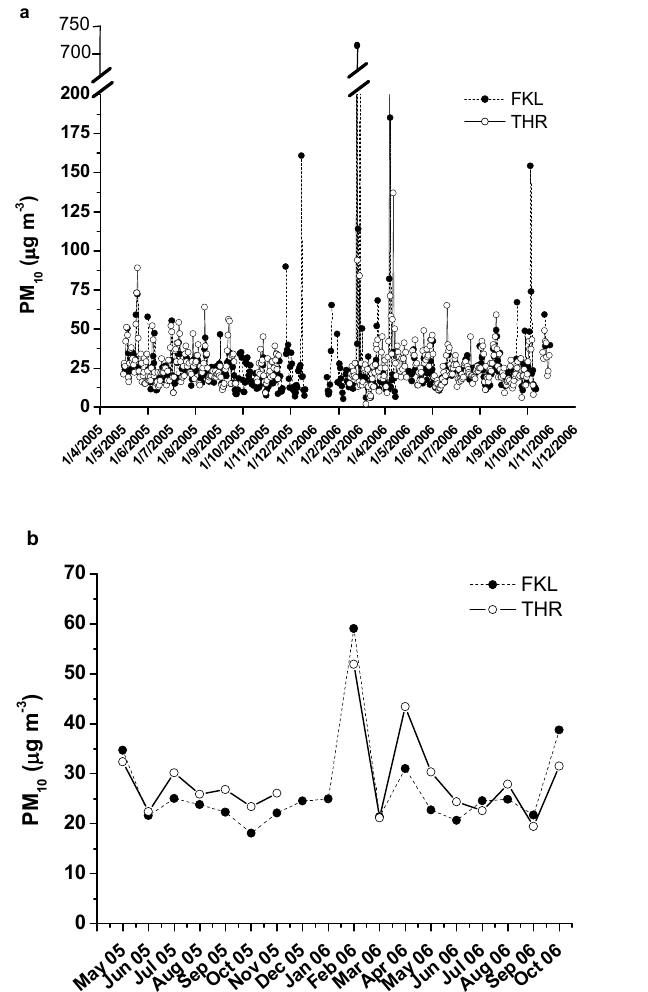
Fig. 3. Daily and monthly mean PM 10 levels at the GAA and FKL from May 2005 to October 2006.